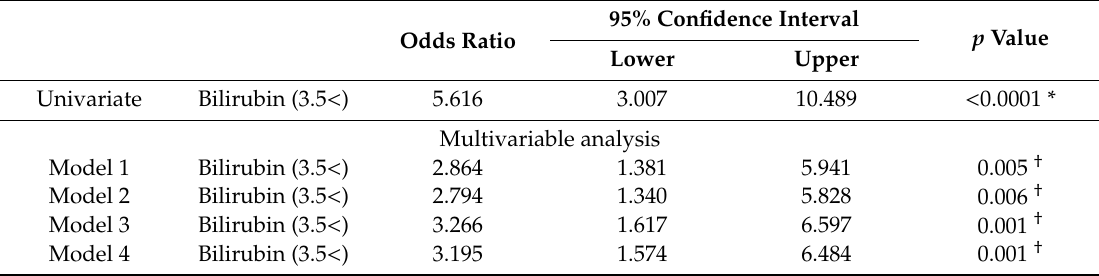
Table 6. Variable analysis of postoperative delirium in patients undergoing liver